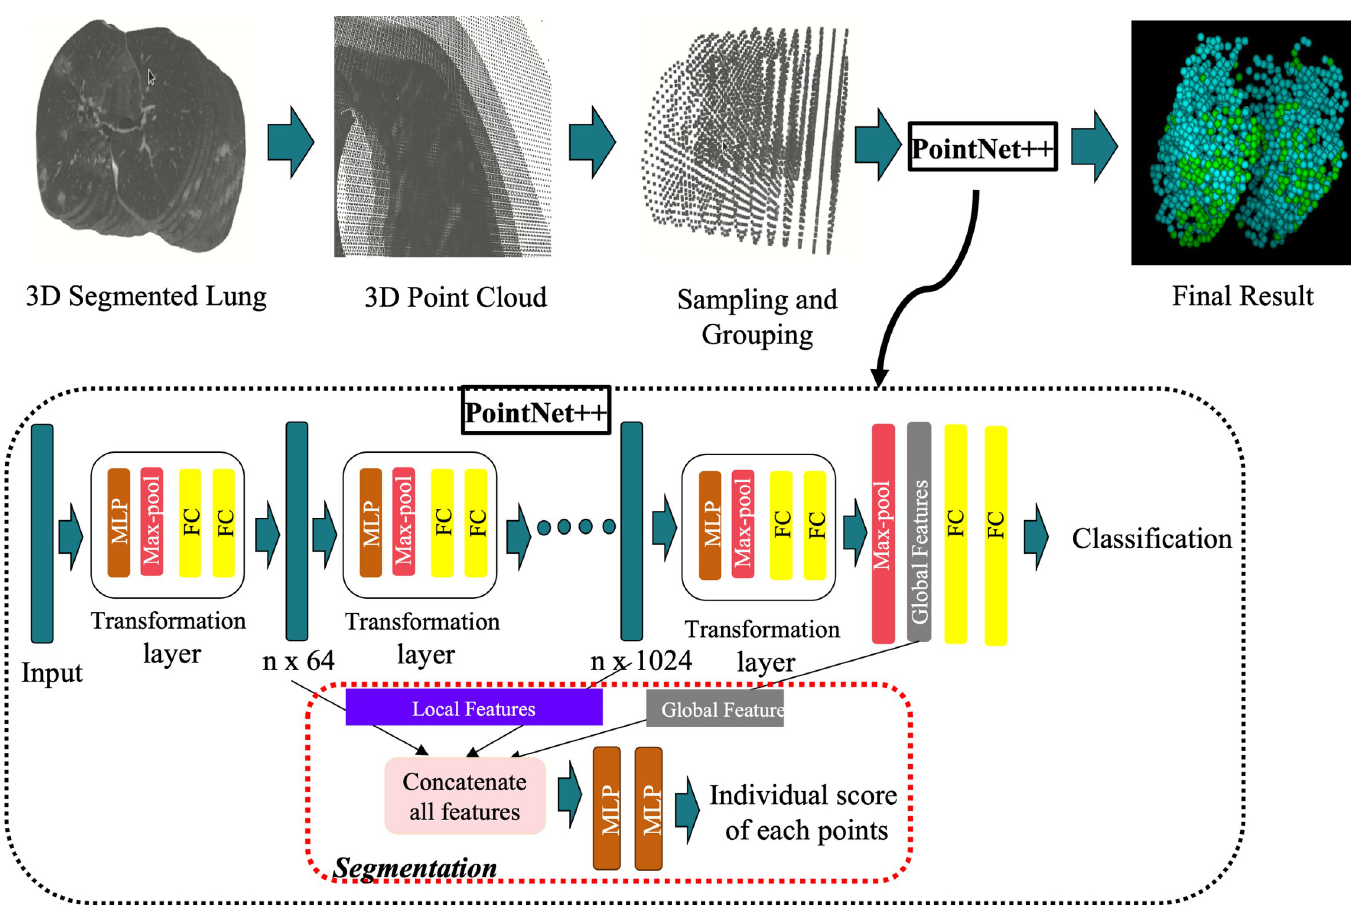
Fig 2. Shows the workflow diagram of the point cloud and PointNet++ for pattern analysis of GGO distribution. The PointNet++ architecture used in this study is the same as the original architecture in [28 and 29]. The data preparation pipeline is new, which we developed for generating point clouds from 3D lung CT scans. We stacked all segmented lung images to construct a 3D image and used sampling and grouping to select 2048 points for point clouds. We fed those points to the PointNet+ + architecture, which was constructed with a multiple set of abstraction layers. Each set abstraction layer consisted of a sampling layer, grouping layer, and PointNet [28]. Multiple set abstraction layers formed a hierarchical feature learning architecture, which was divided into two parts: Segmentation and classification. For data segmentation, we merged local and global features to get the score of individual data points. For classification, global features were fed to two fully connected (FC) layers. MLP—Multilayer